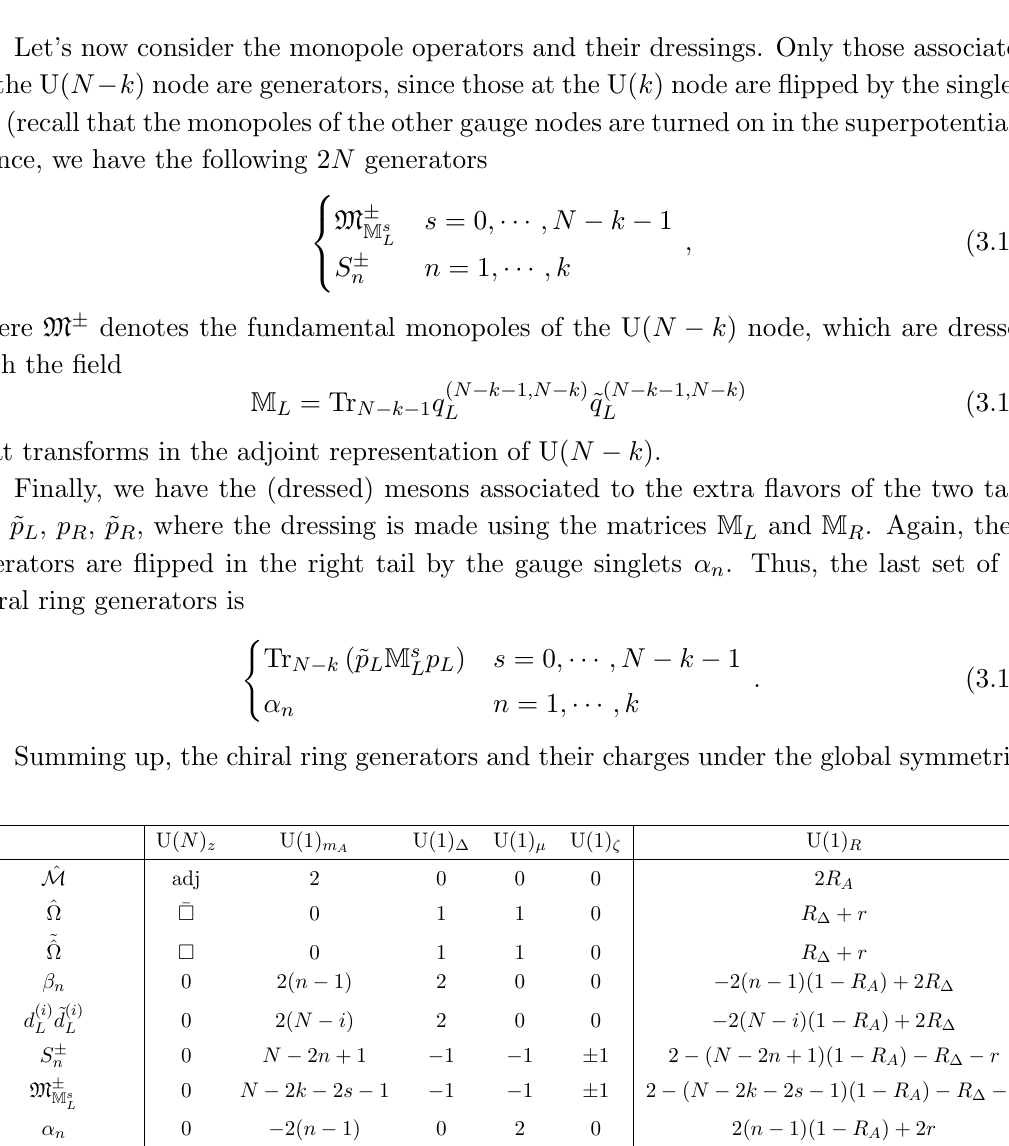
Figure 10 . Diagrammatic representation of the operator ^ M in the case N = 3 and k = 1. Arrows of the same color represent chiral (cid:12)elds that we assemble to construct an element of the matrix. In order to have a gauge invariant operators, we have to consider sequences of arrows that start and end on a squared